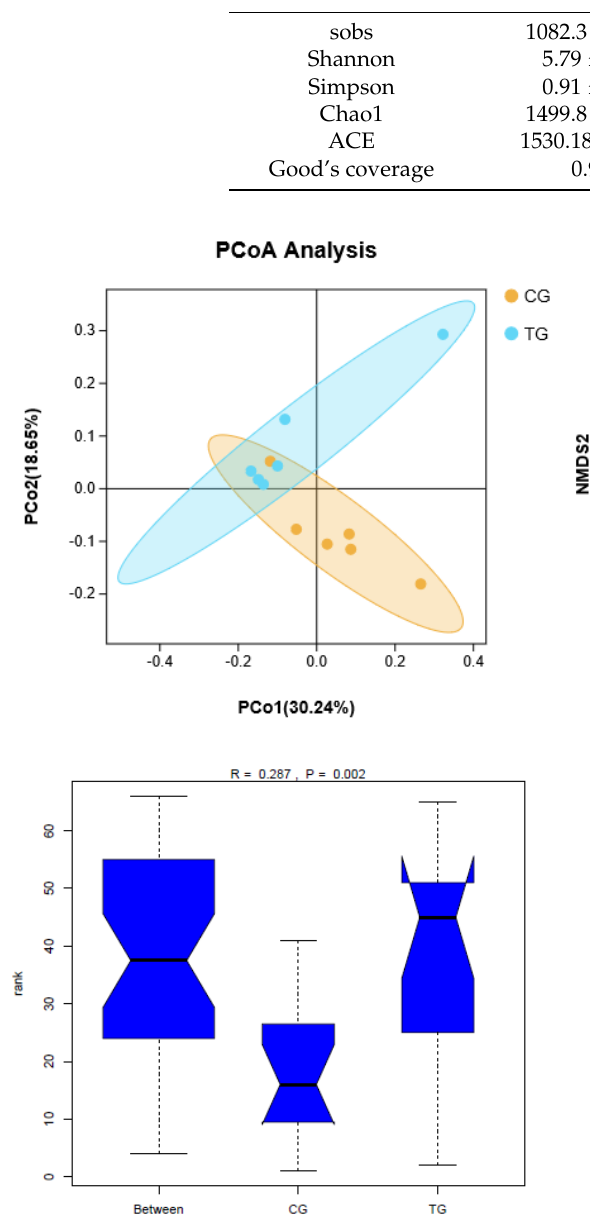
Figure 3. The effects of NH 3 on beta diversity of cecal microbiota in broiler chickens. ( A ) PCoA: Principal coordinates analysis; ( B ) NMDS: Non-metric Multi-Dimensional Scaling. ( C ) Analysis of